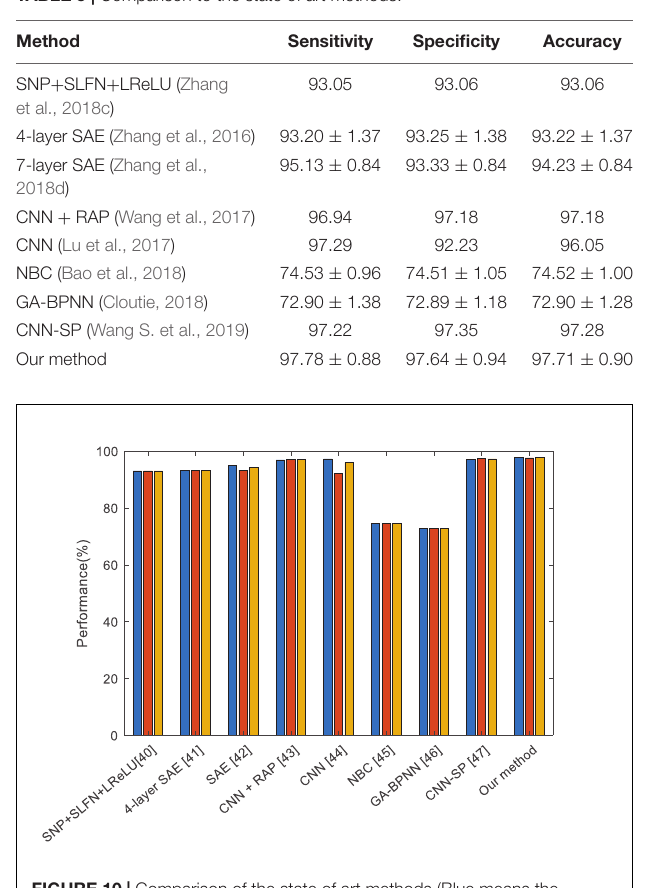
TABLE 5 | Comparison to the state of art methods.